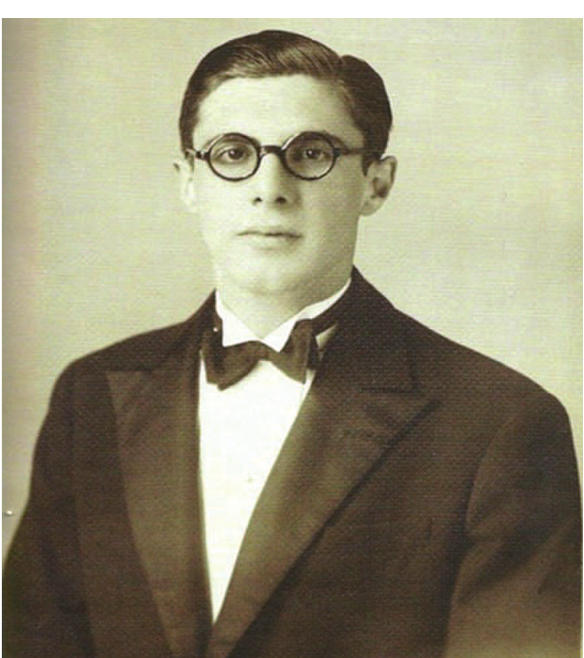
Fig. 2 – Zerbini na ocasião da conclusão do Curso Colegial, hoje ensino médio, em